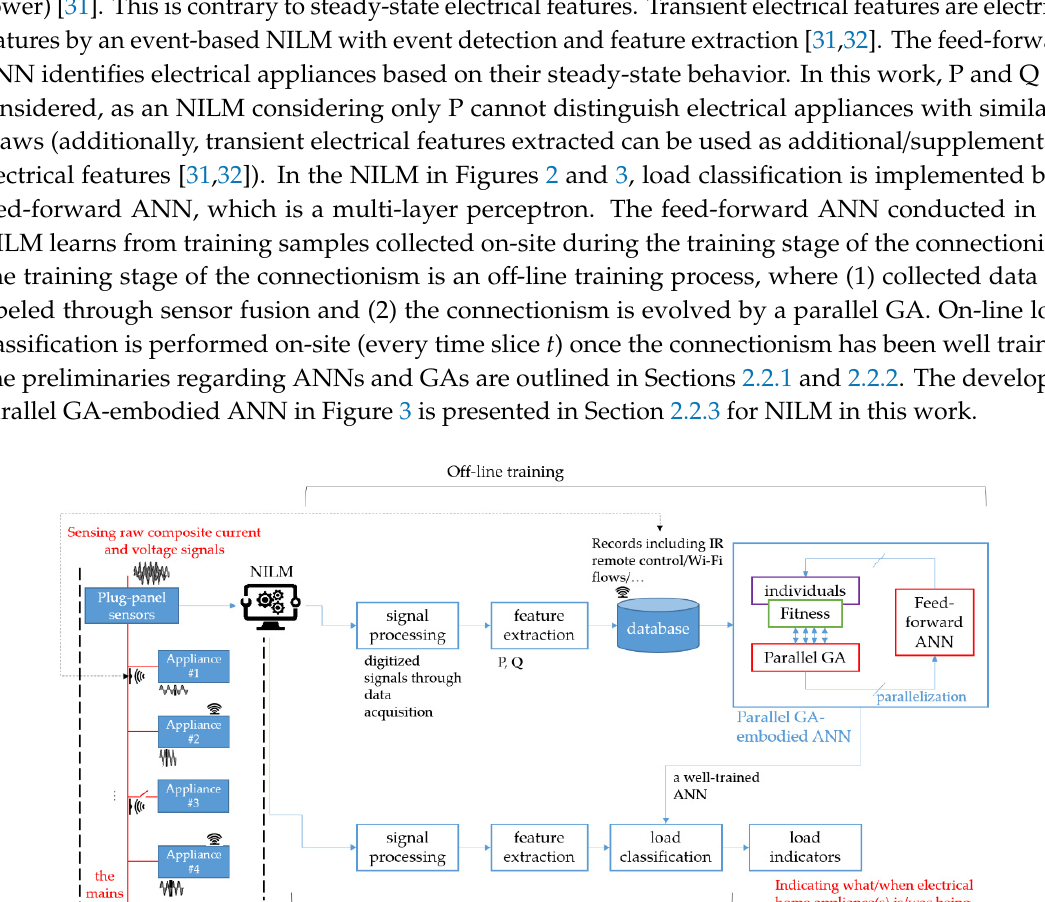
Figure 3. A detailed NILM pipeline in this work.